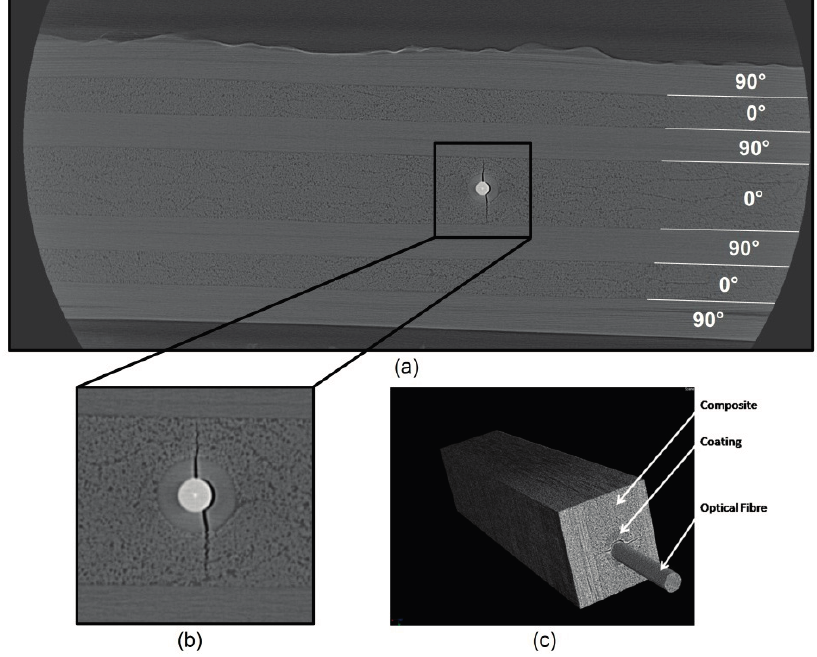
Figure 7. ( a ) 2D cross section reconstruction taken from a micro-CT performed on a CFRP prepreg M18/M55J cross-ply laminate with a coated OFS embedded in the mid-plane and ( b ) enlargement of its surroundings; ( c ) 3D volume rendering of